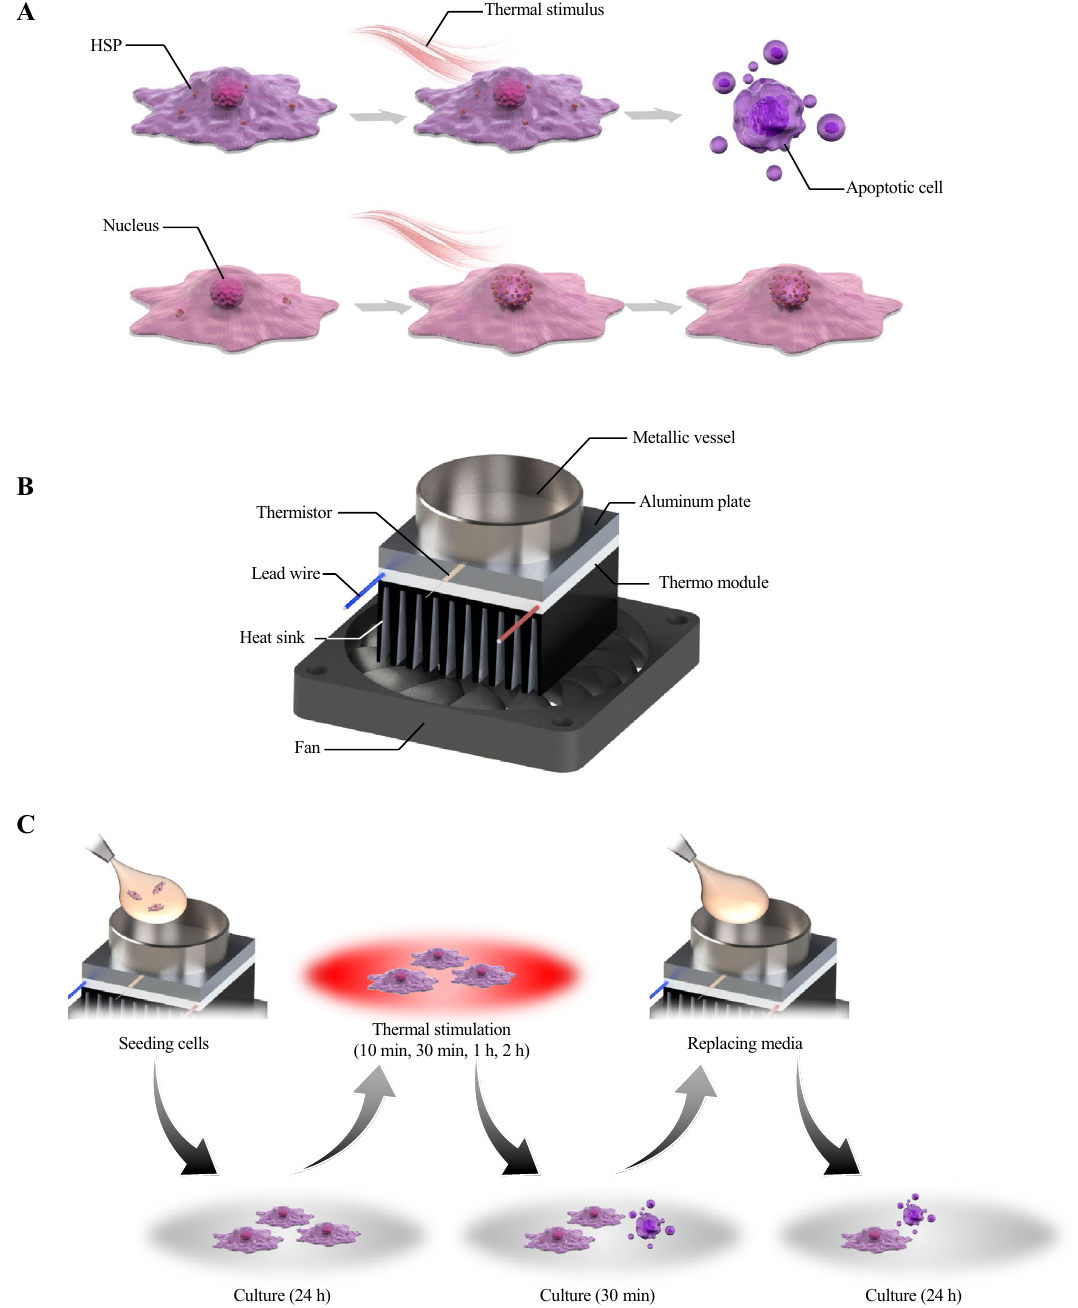
Figure 1. Schematic images showing the concept, the developed device, and the experimental procedure of the present work. Conceptual image of responses of cells to thermal stimulation ( A ), an overview of the thermal stimulus device in which thermal stimulation is applied to cells cultured in a metallic culture vessel having a diameter of 35 mm ( B ), and the experimental procedure to apply a thermal stimulus to cells ( C